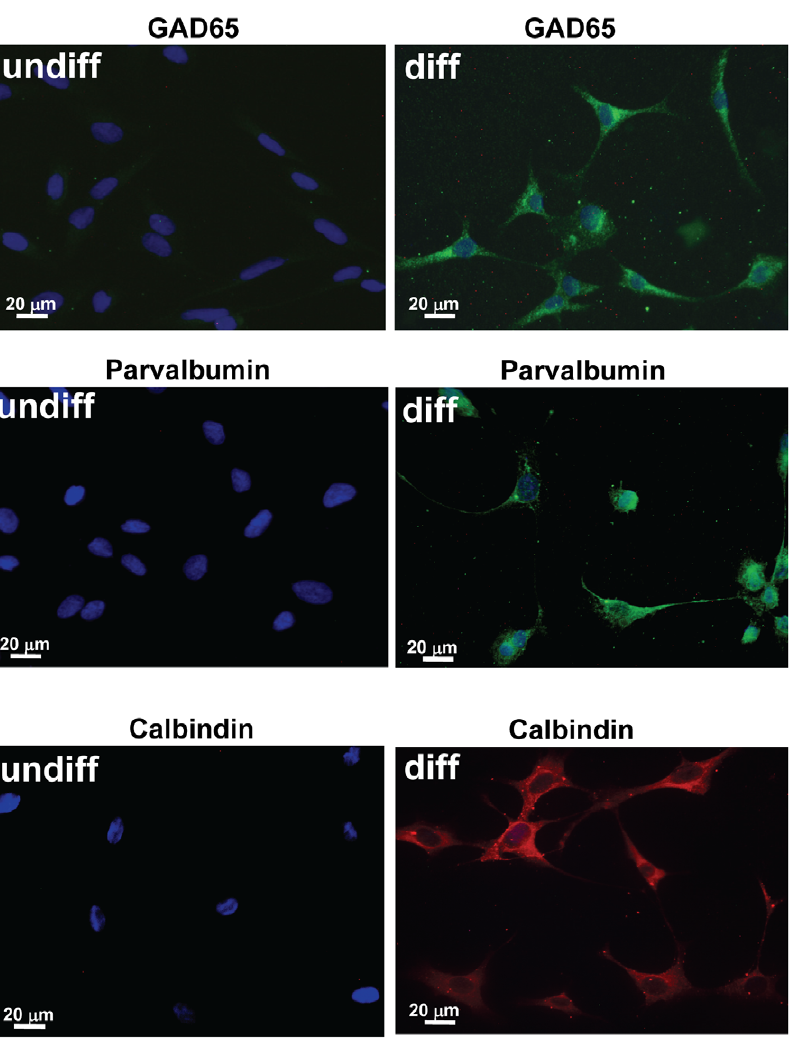
Figure 6. Expression of GAD 65 , parvalbumin and calbindin in undifferentiated and differentiated HiB5 cells. Antibodies were used to detect specific proteins ( A ) GAD 65 (green) ( B ) parvalbumin (green, right) ( C ) expression of calbindin (red). Blue: cell nuclei counter stained with DAPI.